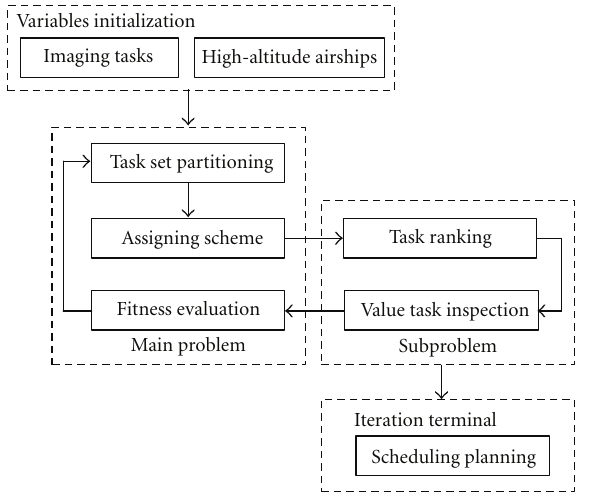
Figure 2: Architecture of cooperative scheduling